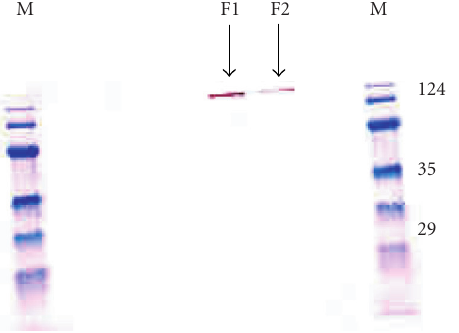
Figure 3. Western blot obtained from transfer of duplicate SDS PAGE gel containing purified fractions of recombinant β - galactosidase expressed by P pastoris GS115/LacZ/mut + cells and showing reaction of the myc-epitope of the recombinant β - galactosidase with the anti-myc-antibody. Purified recombinant β -galactosidase eluted in fractions 1 and 2 (F1 and F2) are in- dicated by band at approximately 124 kd. (F2 band only faintly shown on SDS PAGE gel).